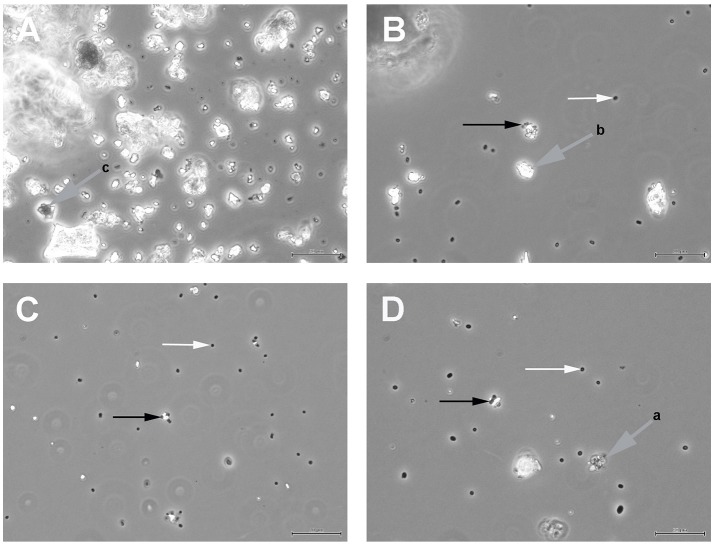
Light microscopic analyses of (A) the coarse suspension of lava from which the fines used for subsequent binding studies was derived; (B)
P. furiosus strain BBR binding to the lava particles; (C)
P. furiosus strain BBR binding to BSM; (D)
P. furiosus strain Vc1 binding to BSM. Size bars: 50 μm for (A); 20 μm for (B–D). White arrows indicate free cells; black arrows indicate particles with adherent cells; gray arrows indicate different types of solids as identified by phase-contrast light microscopy.